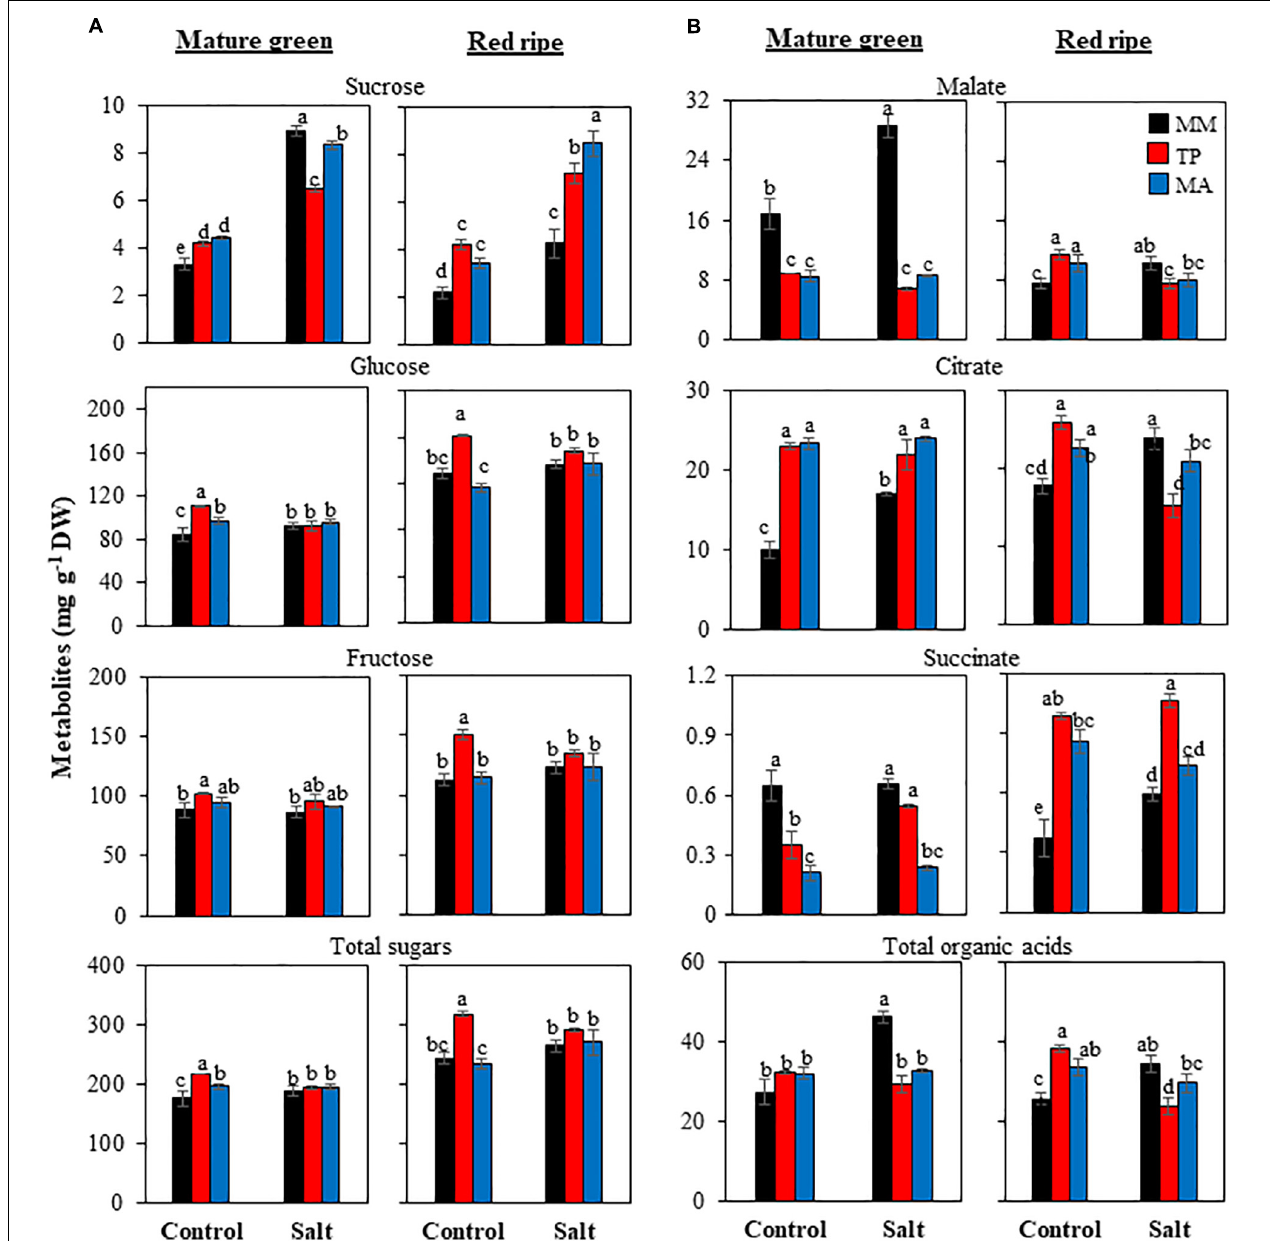
FIGURE 3 | Accumulation of sugars (A) and organic acids (B) in mature green and red ripe fruits of “Moneymaker” (MM) and two traditional varieties, “Tomate Pimiento” (TP) and “Muchamiel Aperado” (MA), from plants grown in control and salt (50 mM NaCl). Three biological replicates of 10 fruits each were used. Values are expressed as means ± SE. Different letters indicate statistically significant differences according to Tukey’s test ( p < 0.05).